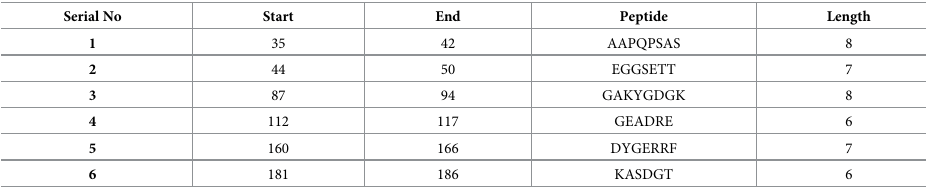
Table 10. Results from Emini surface accessibility prediction.